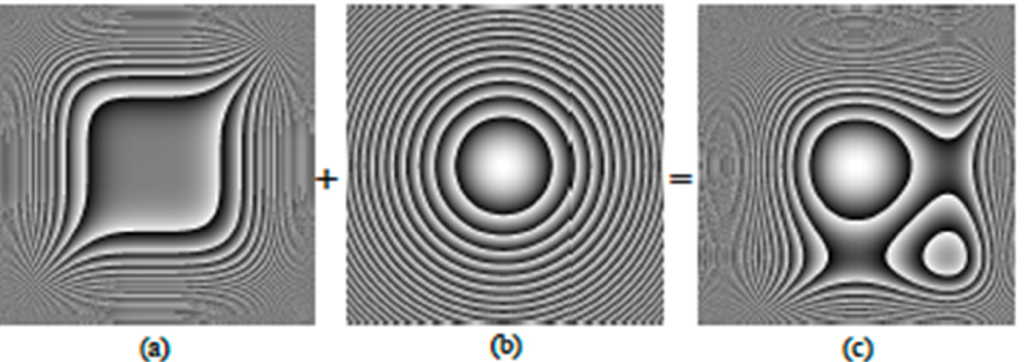
Figure 3. Grey level modulo-2 π phase distributions of the combined APM + FL system. ( a ) APM with n = 4 and optimal α = 31.9 = 100/ π ; ( b ) FL with focal length f = 500 mm; ( c ) sum of the APM and FL phases.